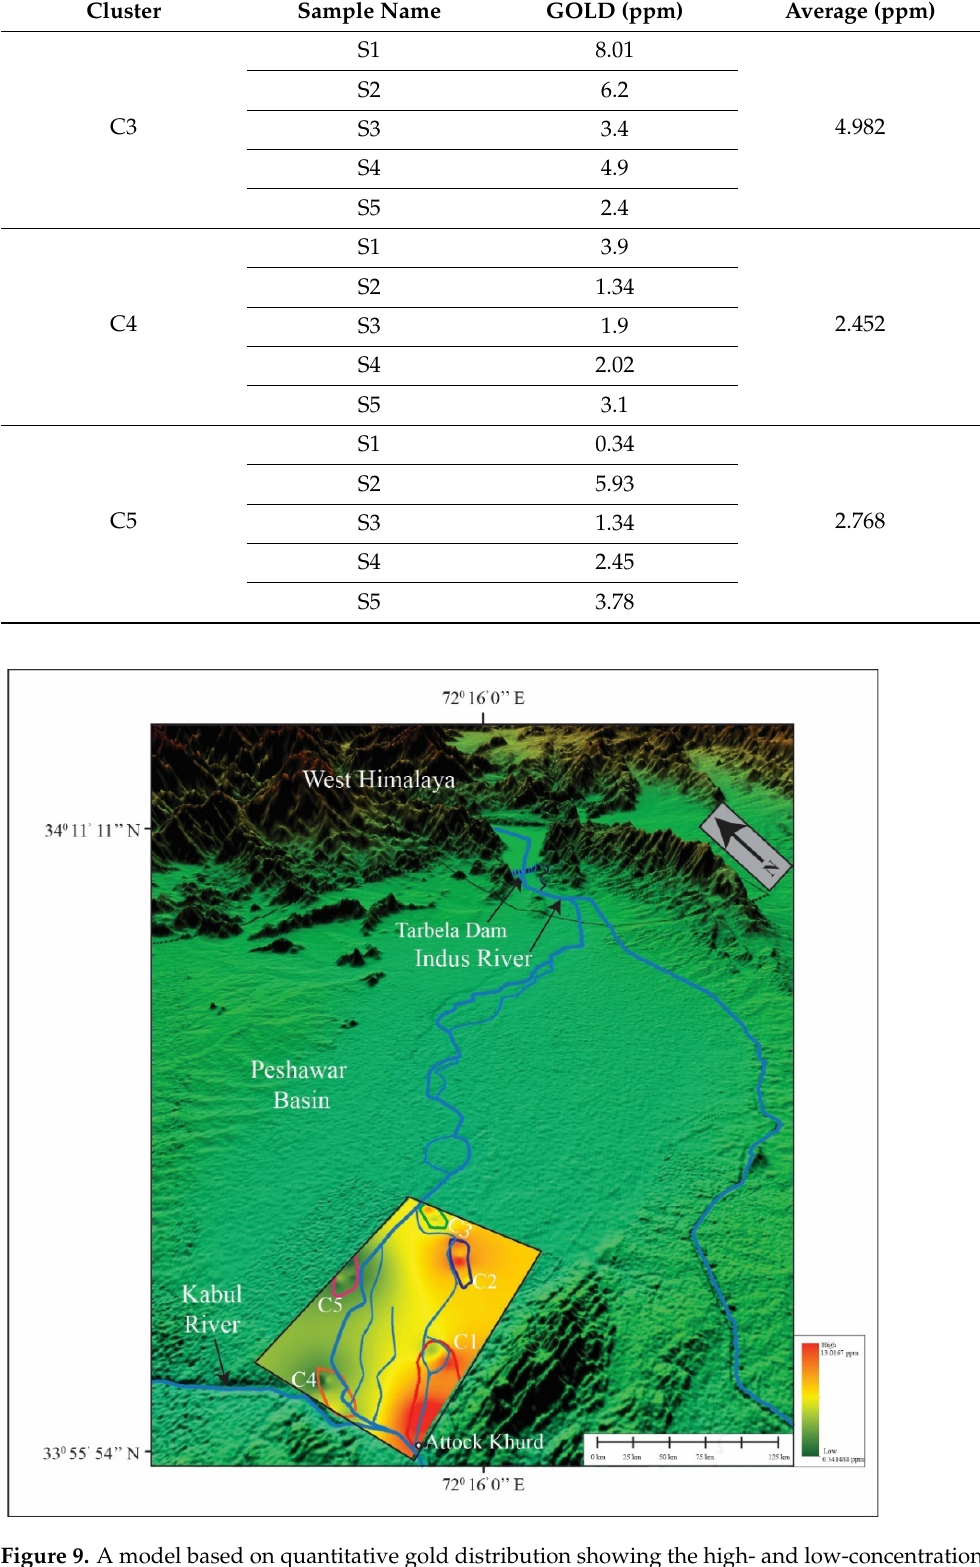
Figure 9. A model based on quantitative gold distribution showing the high- and low-concentration zones of gold (ppm) in the study area deposited through the Indus River from